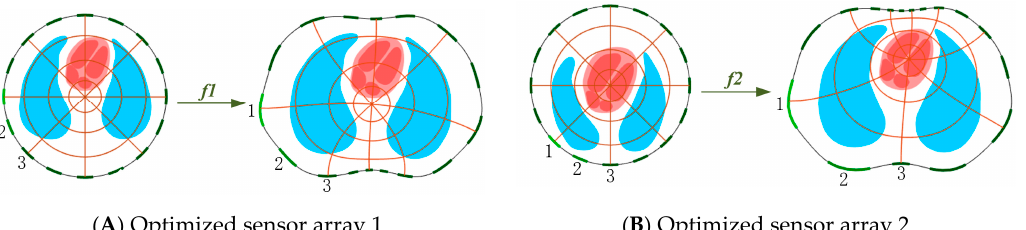
Figure 4. Two mapping processes, taking the center of the thoracic region as the mapping origin ( A ) and taking the center of the heart region as the mapping origin ( B ).